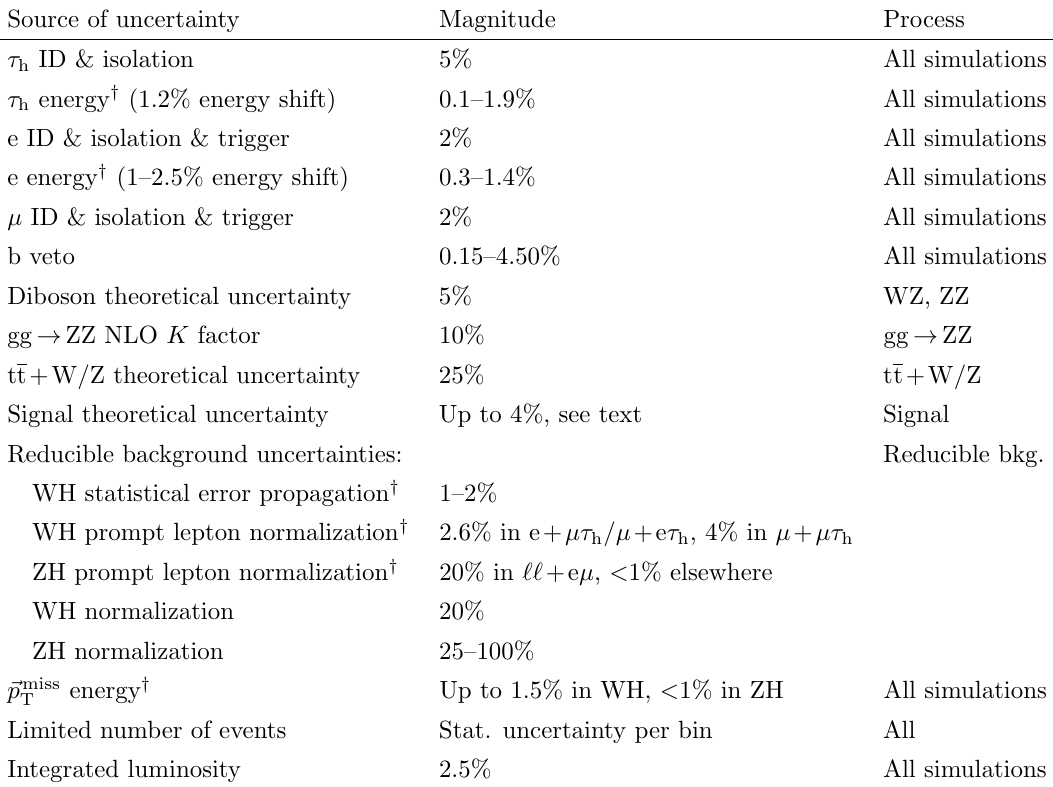
Table 2 . Sources of systematic uncertainty. The sign y marks the uncertainties that are both shape- and rate-based. Uncertainties that a(cid:11)ect only the normalizations have no marker. For the shape and normalization uncertainties, the magnitude column lists the range of the associated change in normalization, which varies by process and (cid:12)nal state. The last column speci(cid:12)es the processes a(cid:11)ected by each source of